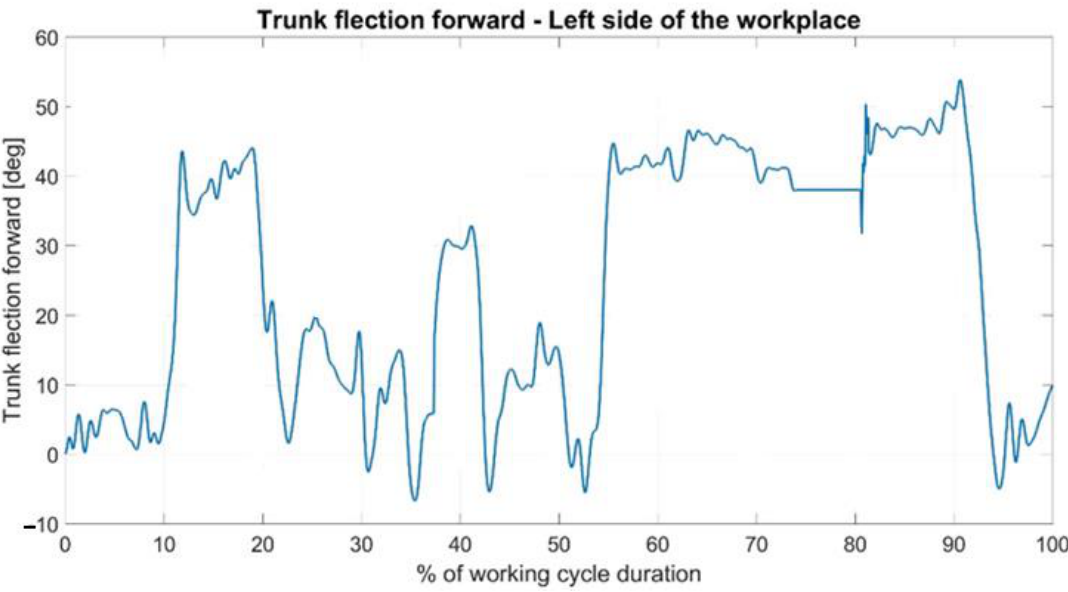
Figure 9. Kinematic signal of trunk flexion forward in one working cycle (left side of the work- station).